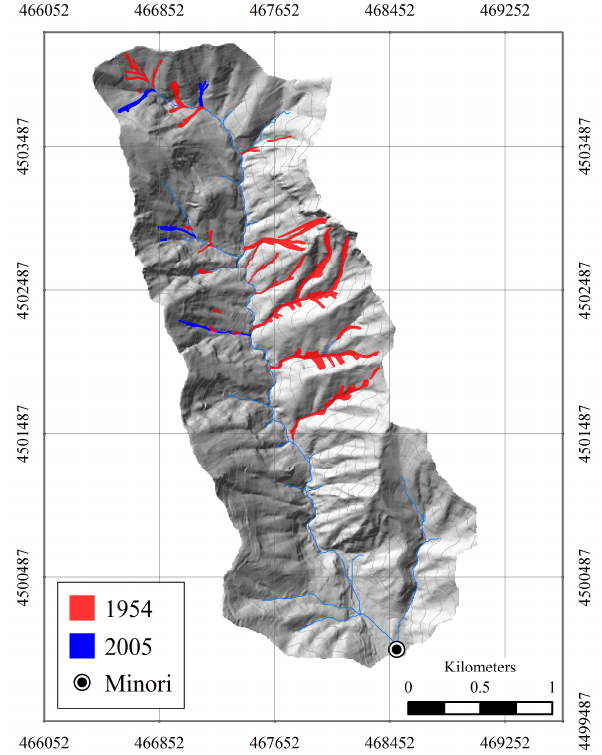
Fig. 4. Traces of the landslides that occurred in 1954 and 2005 (Papa et al., Figure 4. Traces of the landslides that occurred in 1954 and 2005 (Papa et al. 2011a). 2